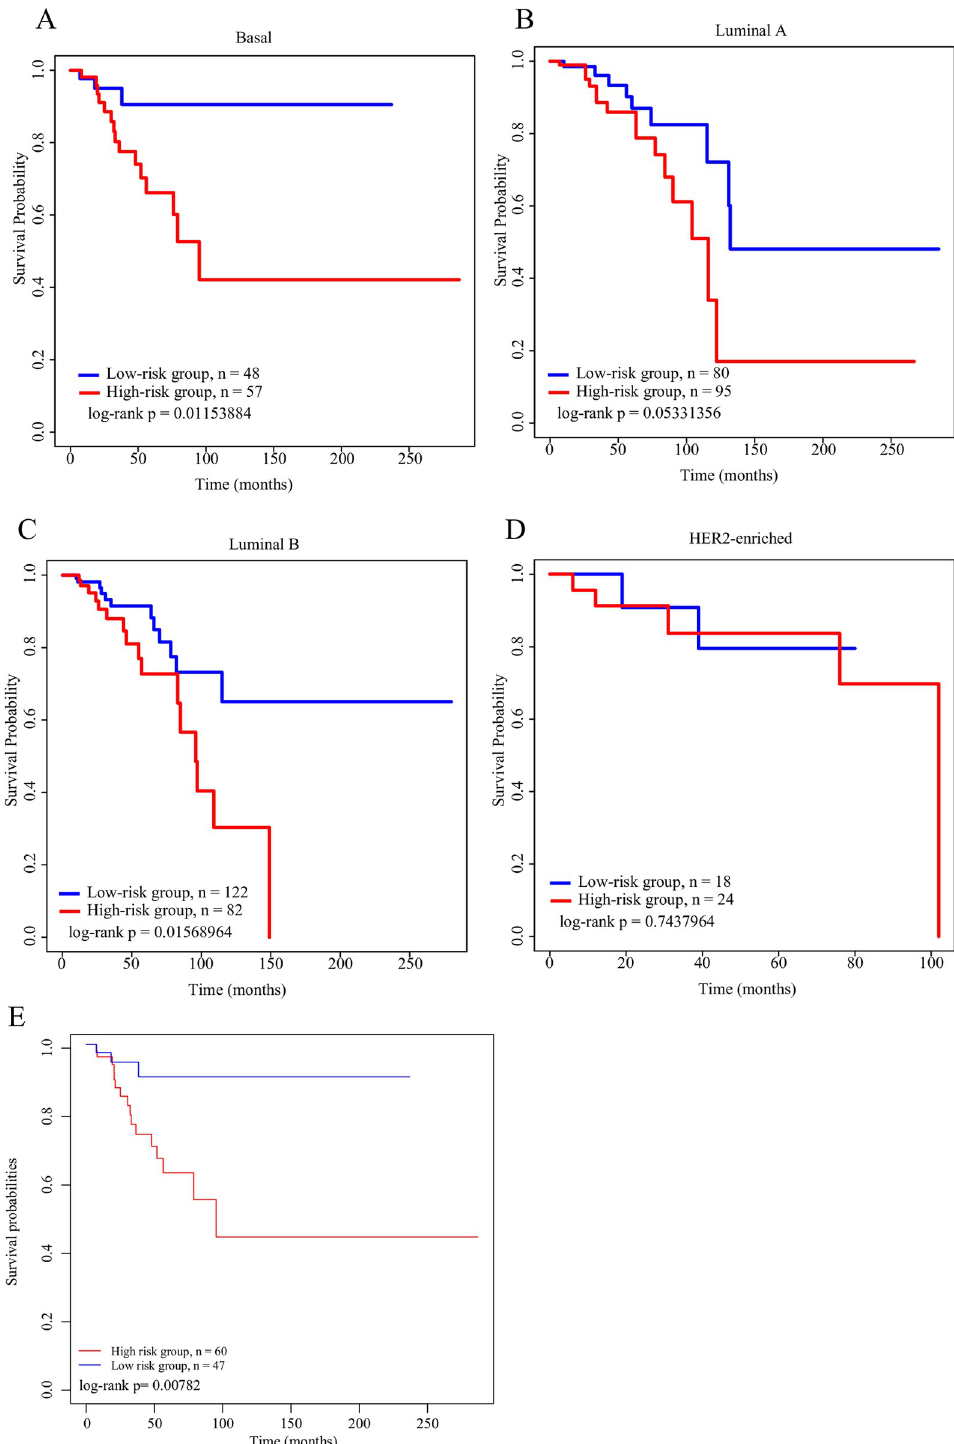
Fig 6. A: KM survival curves of the distribution of the 6-gene signature in breast cancer subtypes Basal. B: KM survival curves of the distribution of the 6-gene signature in breast cancer subtypes Luminal A. C: KM survival curves of the distribution of the 6-gene signature in breast cancer subtypes Luminal B. D: KM survival curves of the distribution of the 6-gene signature in breast cancer subtypes Her2-enriched. E: KM survival curves of the distribution of the 6-gene signature in breast cancer subtypes triple negative breast